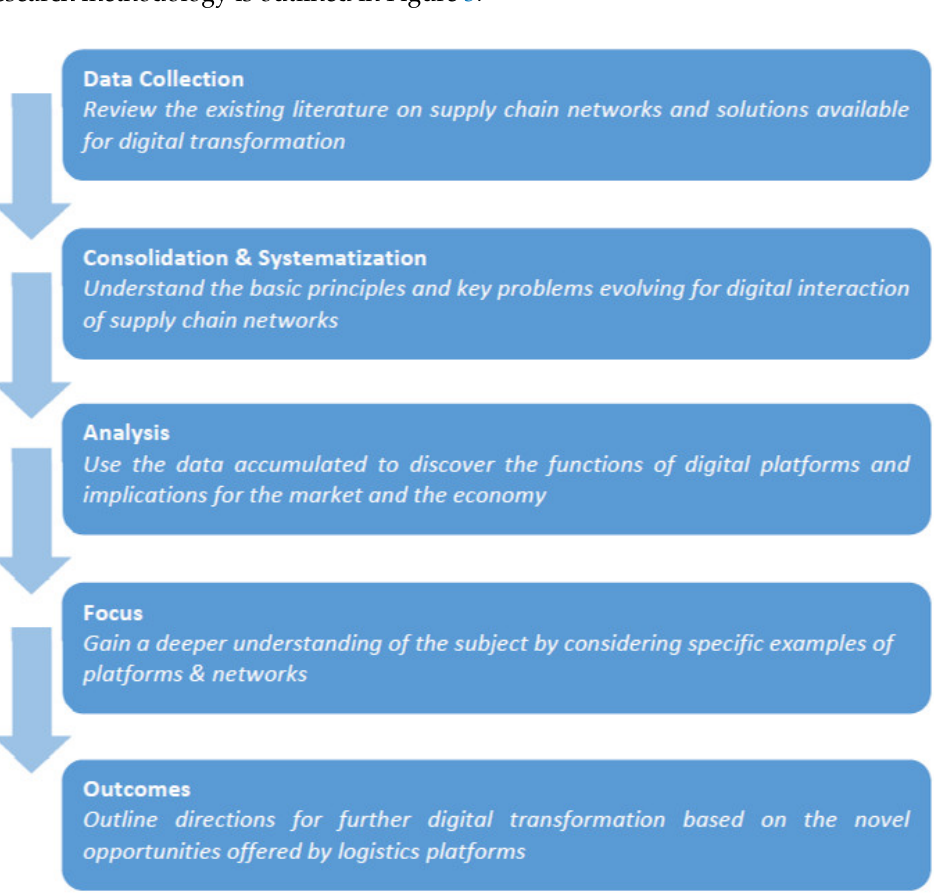
Figure 3. Flowchart of research methodology.